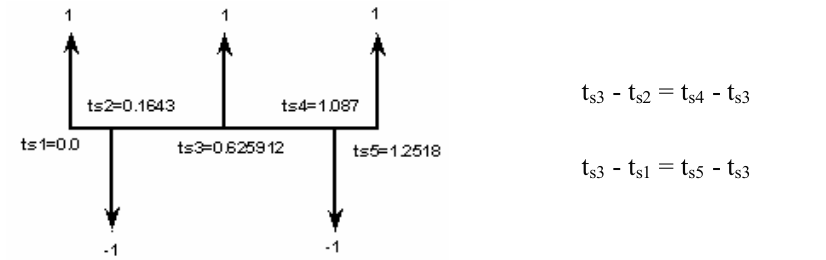
Fig. 8. The structure of the time delay filter for the overhead crane.